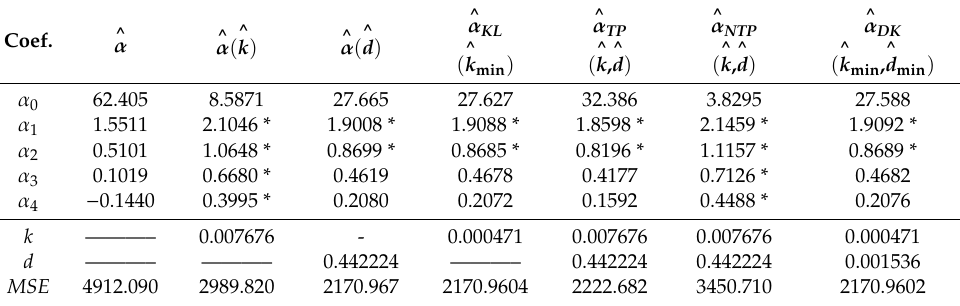
Table 5. The results of regression coe ffi cients and the corresponding MSE